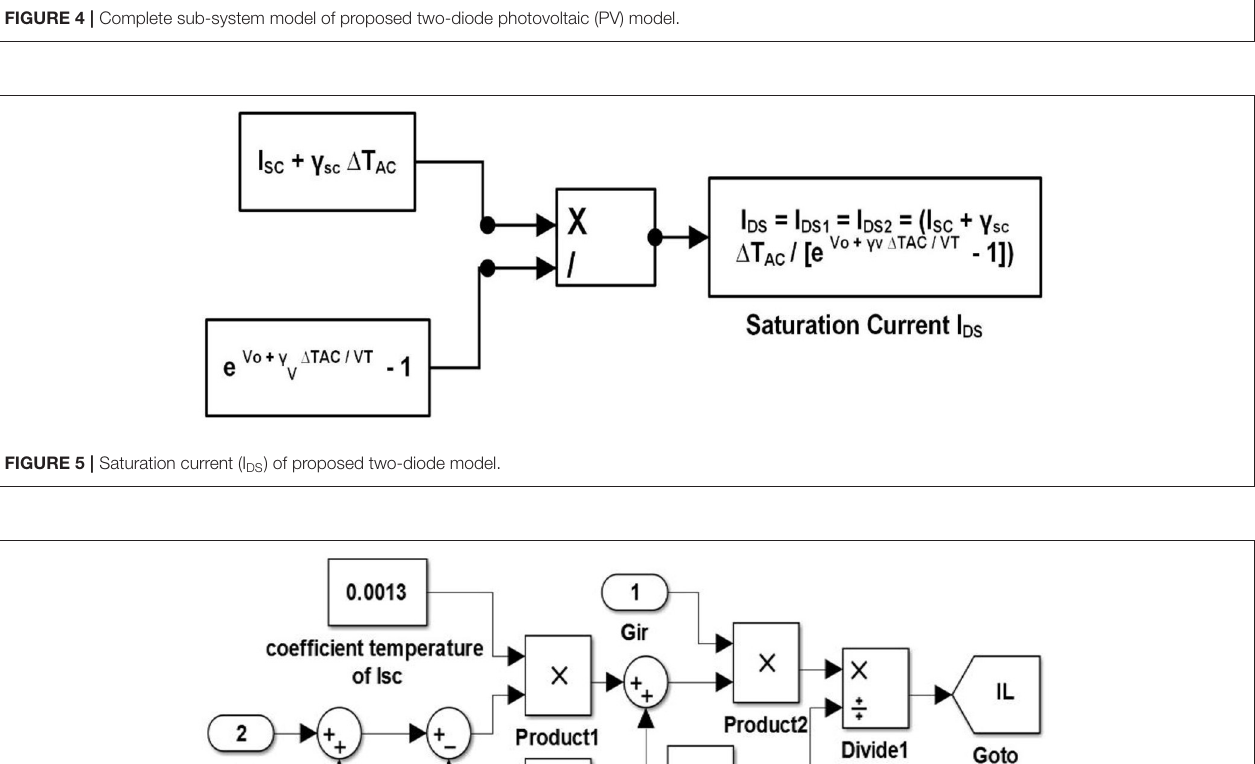
Frontiers in Physics | www.frontiersin.org